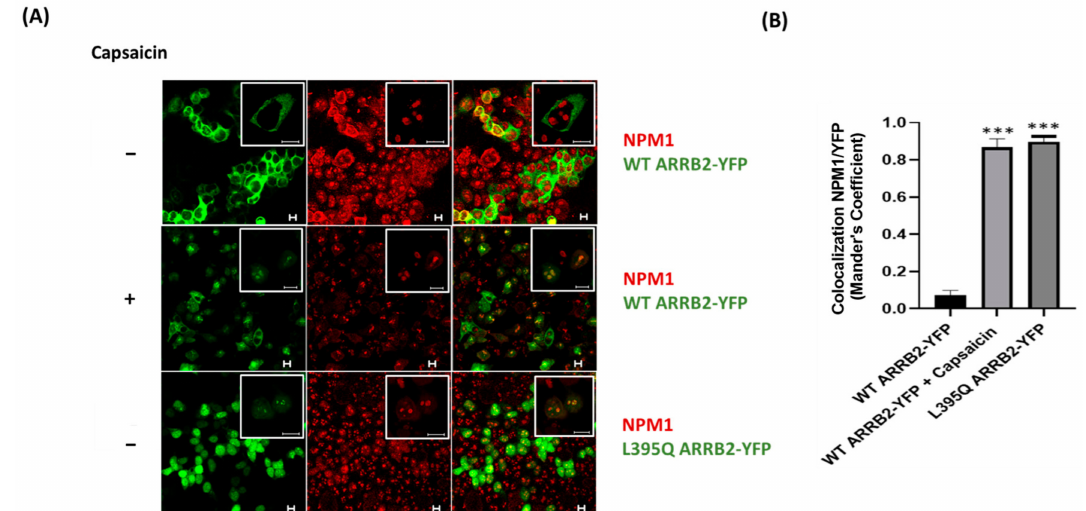
Figure 1. TRPV1 induces ARRB2 shuttling to the nucleolus. ( A ) Representative confocal images of co-localization between NPM1 (red) and ARRB2 (green) in HEK293 cell transfected with plasmids expressing TRPV1 and ARRB2–YFP or the NES mutant L395Q ARRB2-YFP, without or with 1 µ M capsaicin for 15 min. Scale bars, 10 µ m. Images are representatives of 3 independent experiments. ( B ) Quantification of the colocalization between NPM1 and YFP using the Mander’s coefficient in ImageJ. Note that NPM1 is colocalized with L395Q ARRB2-YFP mutant or WT ARRB2-YFP, after capsaicin treatment. Sample means are plotted ± SEM. Statistical analyses were performed using Kruskal–Wallis test; *** p <